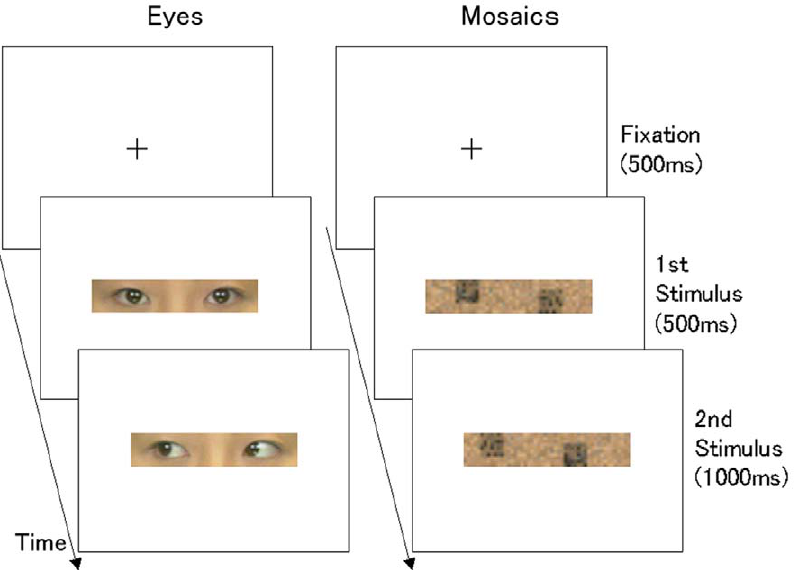
Figure 2. Illustrations of stimulus presentations. Straight–averted direction conditions of eyes and mosaic stimuli are shown.